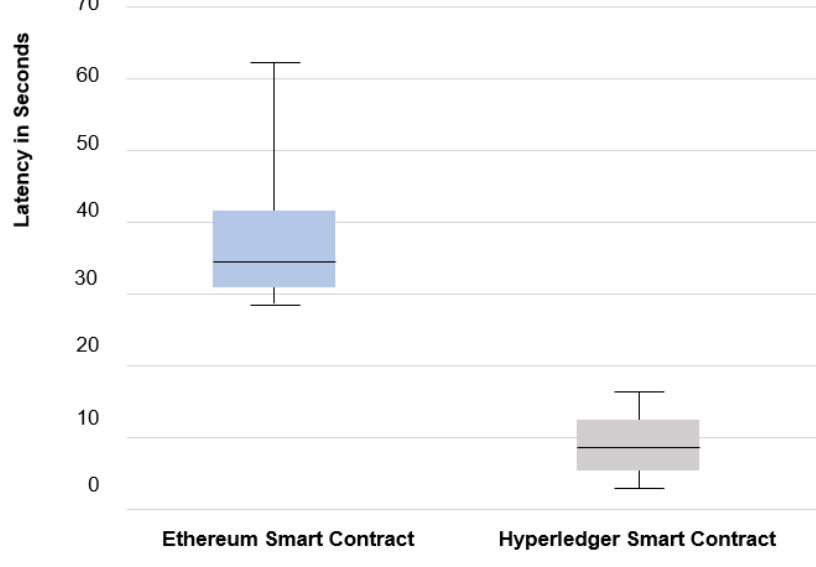
Figure 4. Latency Comparison Between Ethereum based Smart Contract and Hyperledger based Smart Contract.